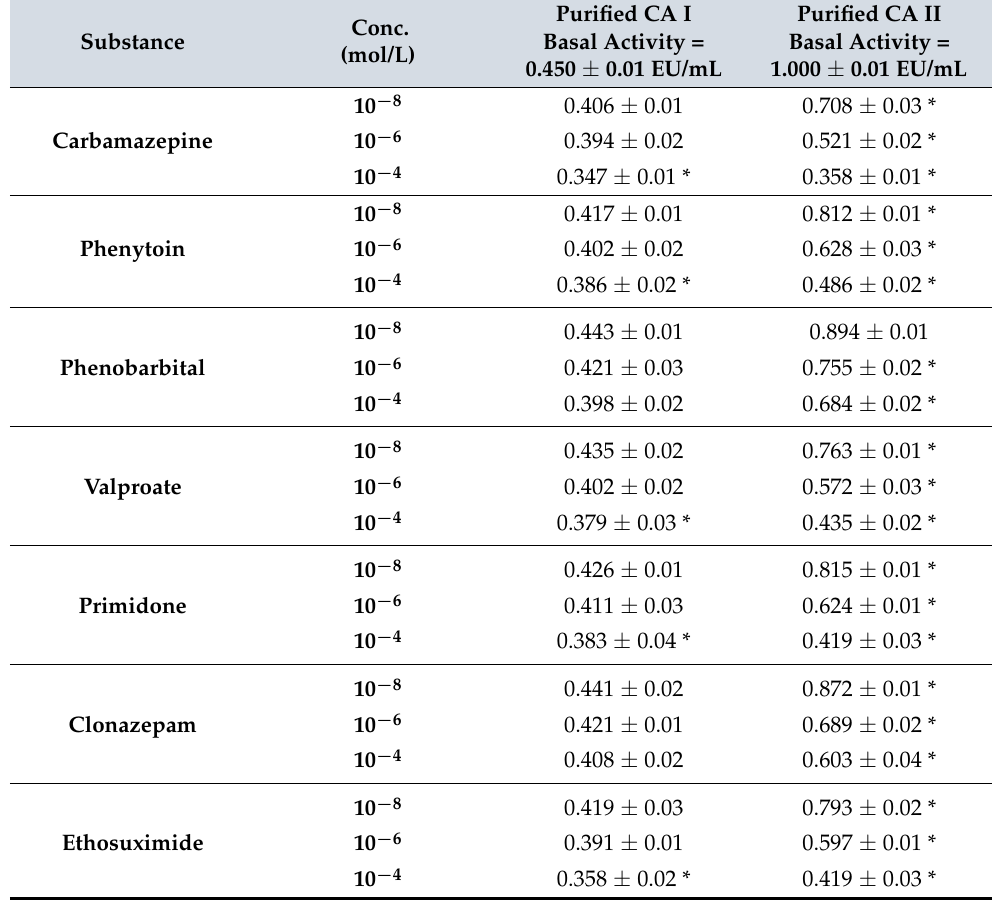
Table 1. The effect of antiepileptic drugs on carbonic anhydrase